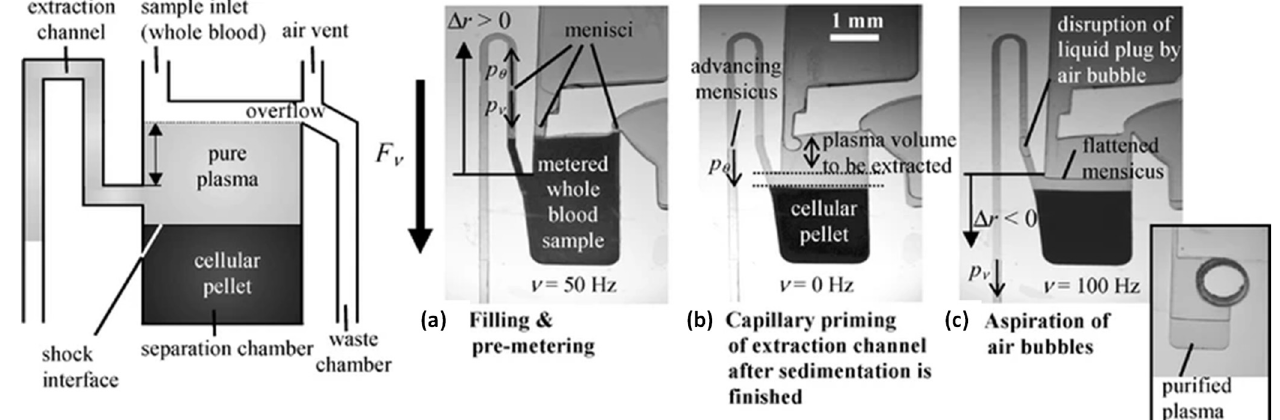
Figure 3. Sketch of the plasma extraction structure. ( a ) After injection through the inlet, a droplet of raw blood is pre-metered. ( b ) The shock interface separating pure plasma and cellular blood proceeds and stops at a position radially outwards compared to the extraction channel. Then, the disk is stopped, and the extraction channel is filled by the capillary pressure p θ . ( c ) If the net radial length ∆ r between the downstream meniscus and the liquid level in the separation chamber is negative, a centrifugal pressure p ν exists to pump the plasma through the extraction channel until air is sucked into the extraction channel. The extracted plasma is collected in a reservoir attached to the extraction channel for further use. Permission granted by the publisher [43].